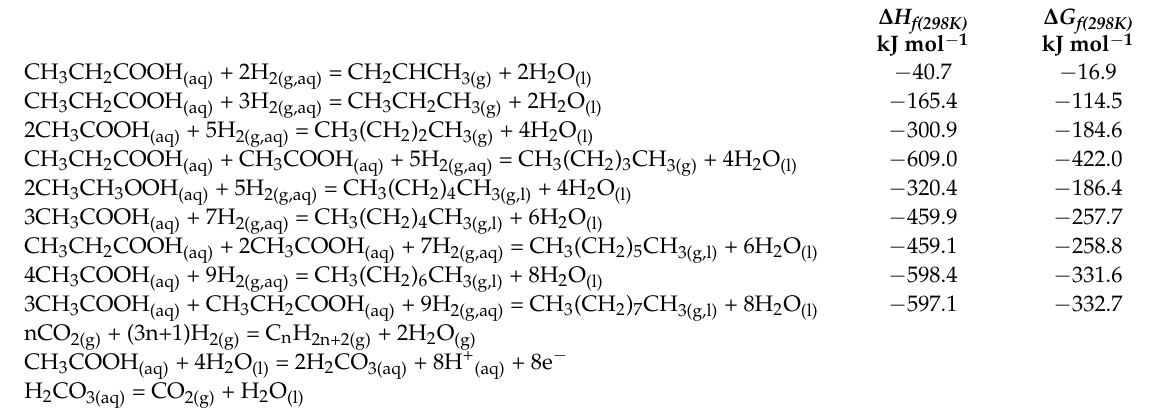
Table 3. C x H y Formational equations implied by product gas compositions. The Equations 1 to 9 are Group 2 reactions, which assume that ethanoic acid and propionic acid form alkanes as a direct degradation product. Equation 10 is alkane production using the Group 3 reaction where the gas feed stock is CO 2 . Equations 11 and 12 provide the aqueous degradation reaction for ethanoic acid to form carbonic acid and CO 2 . ∆ H f(298K) = heat of formation for the reaction at 298 K, P = 0.1 MPa; ∆ G f(298K) = Gibbs free energy for the reaction at 298 K, P = 0.1 MPa. ∆ H f(298K) and ∆ G f(298K) calculated using the methodology defined by [31], and the data sources defined in Appendix A.4.